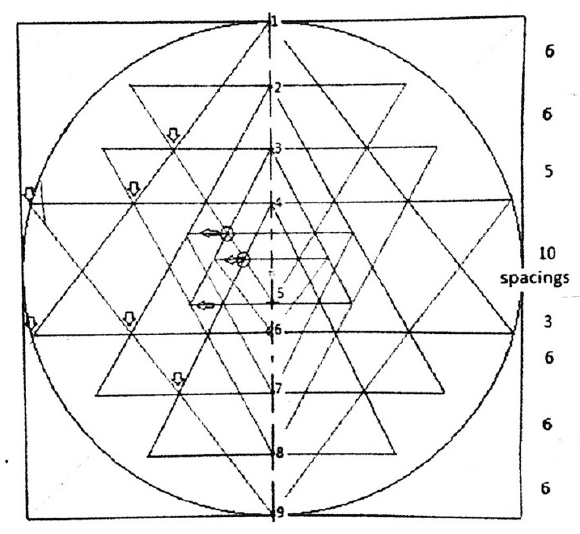
Figure 10. Instructions to draw the Ś r ī cakra. Credit: Saraswati (2016, p. 148).